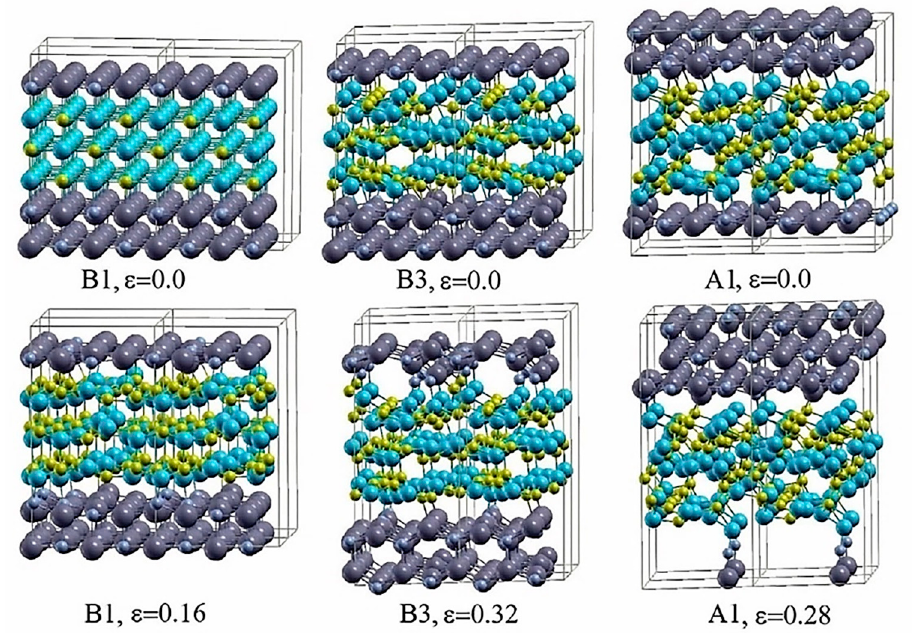
Figure 21. Atomic configurations of the TiN(001)/SiC heterostructures prior elongation (top row) and just after failure (bottom row). Reprinted with permission from [152] 2018 Elsevier.